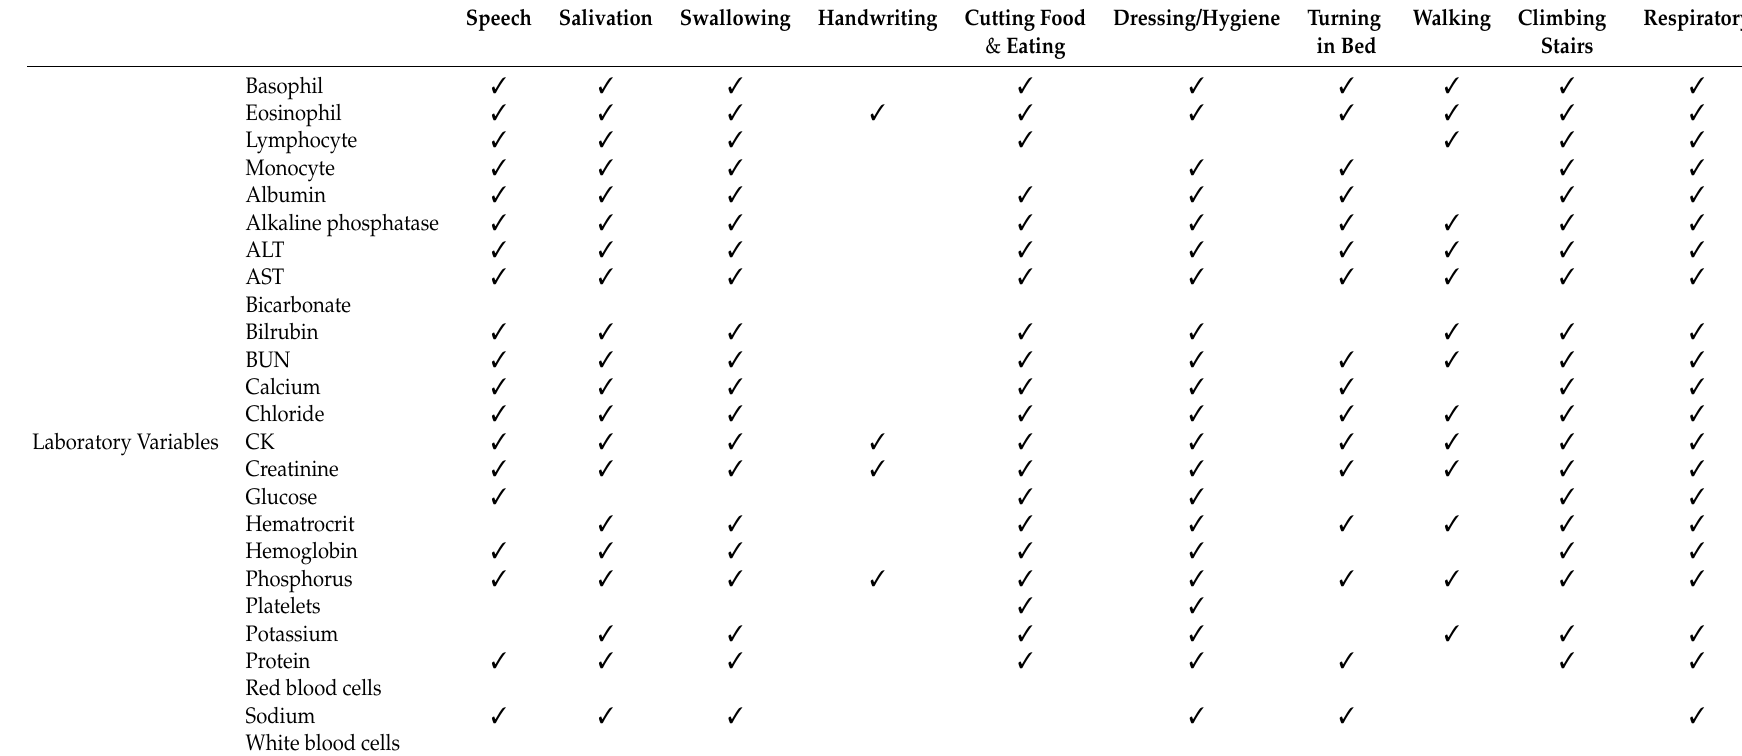
Table 2. Summary of lab test feature selection for each ALSFRS